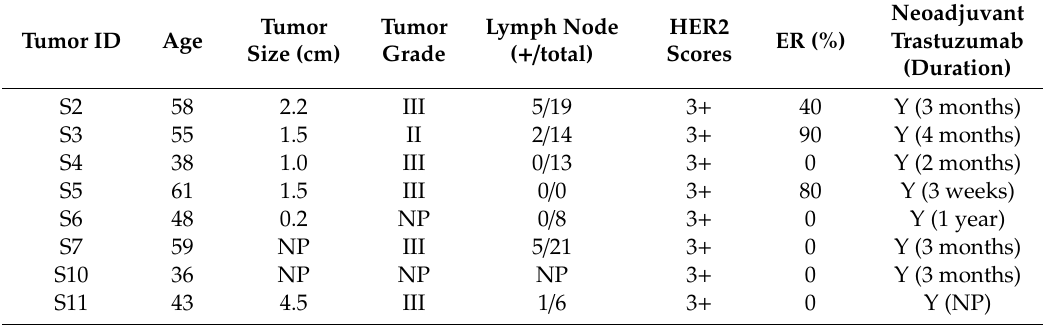
Table 1. Cohort clinical